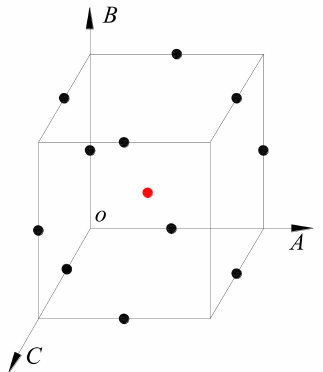
Figure 3. Box–Behnken design model for three